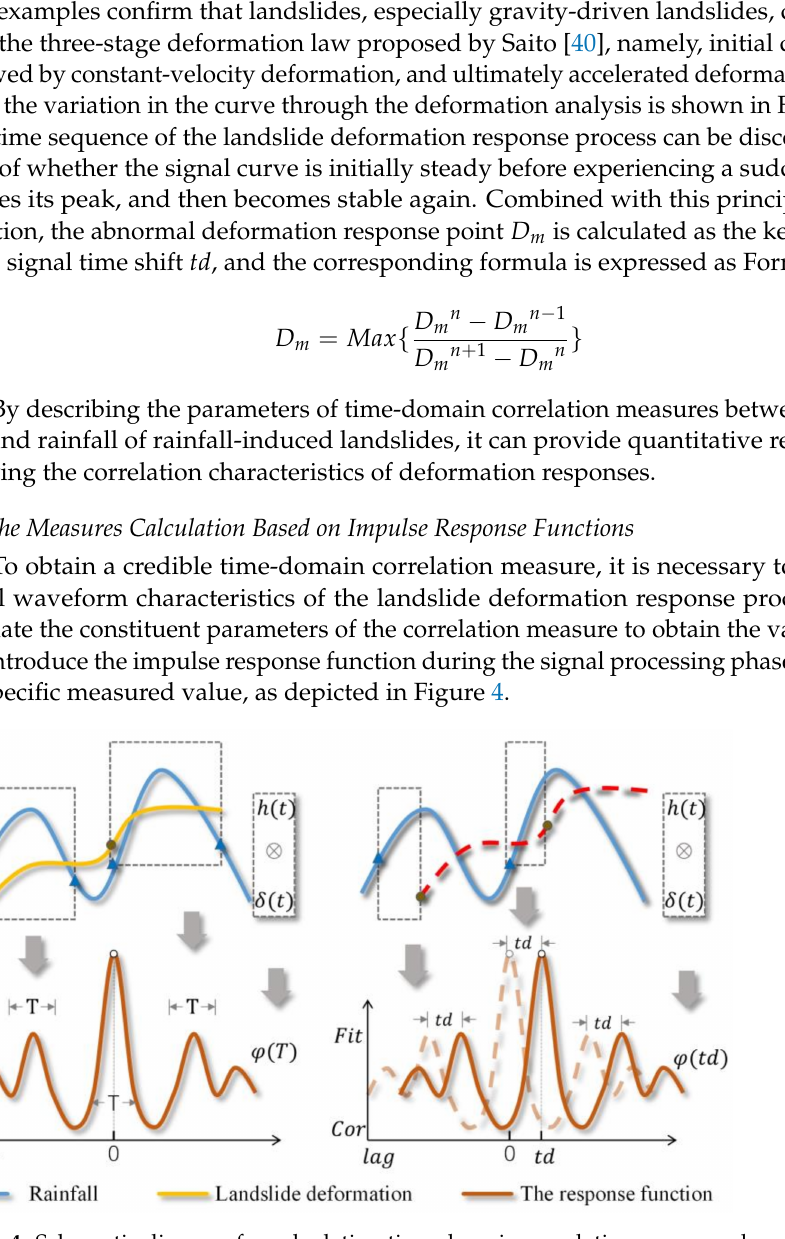
Figure 4. Schematic diagram for calculating time-domain correlation measures based on impulse response